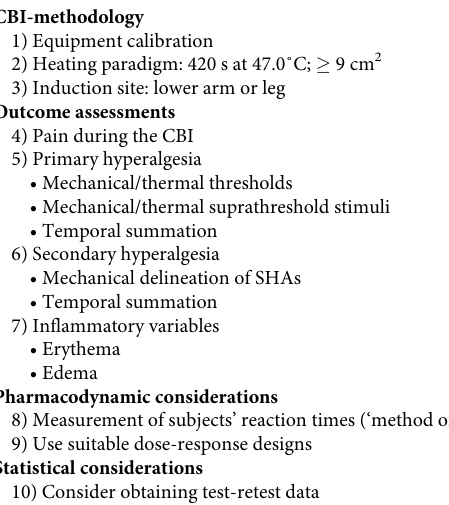
Table 4. Suggestions to consider when designing a CBI-model